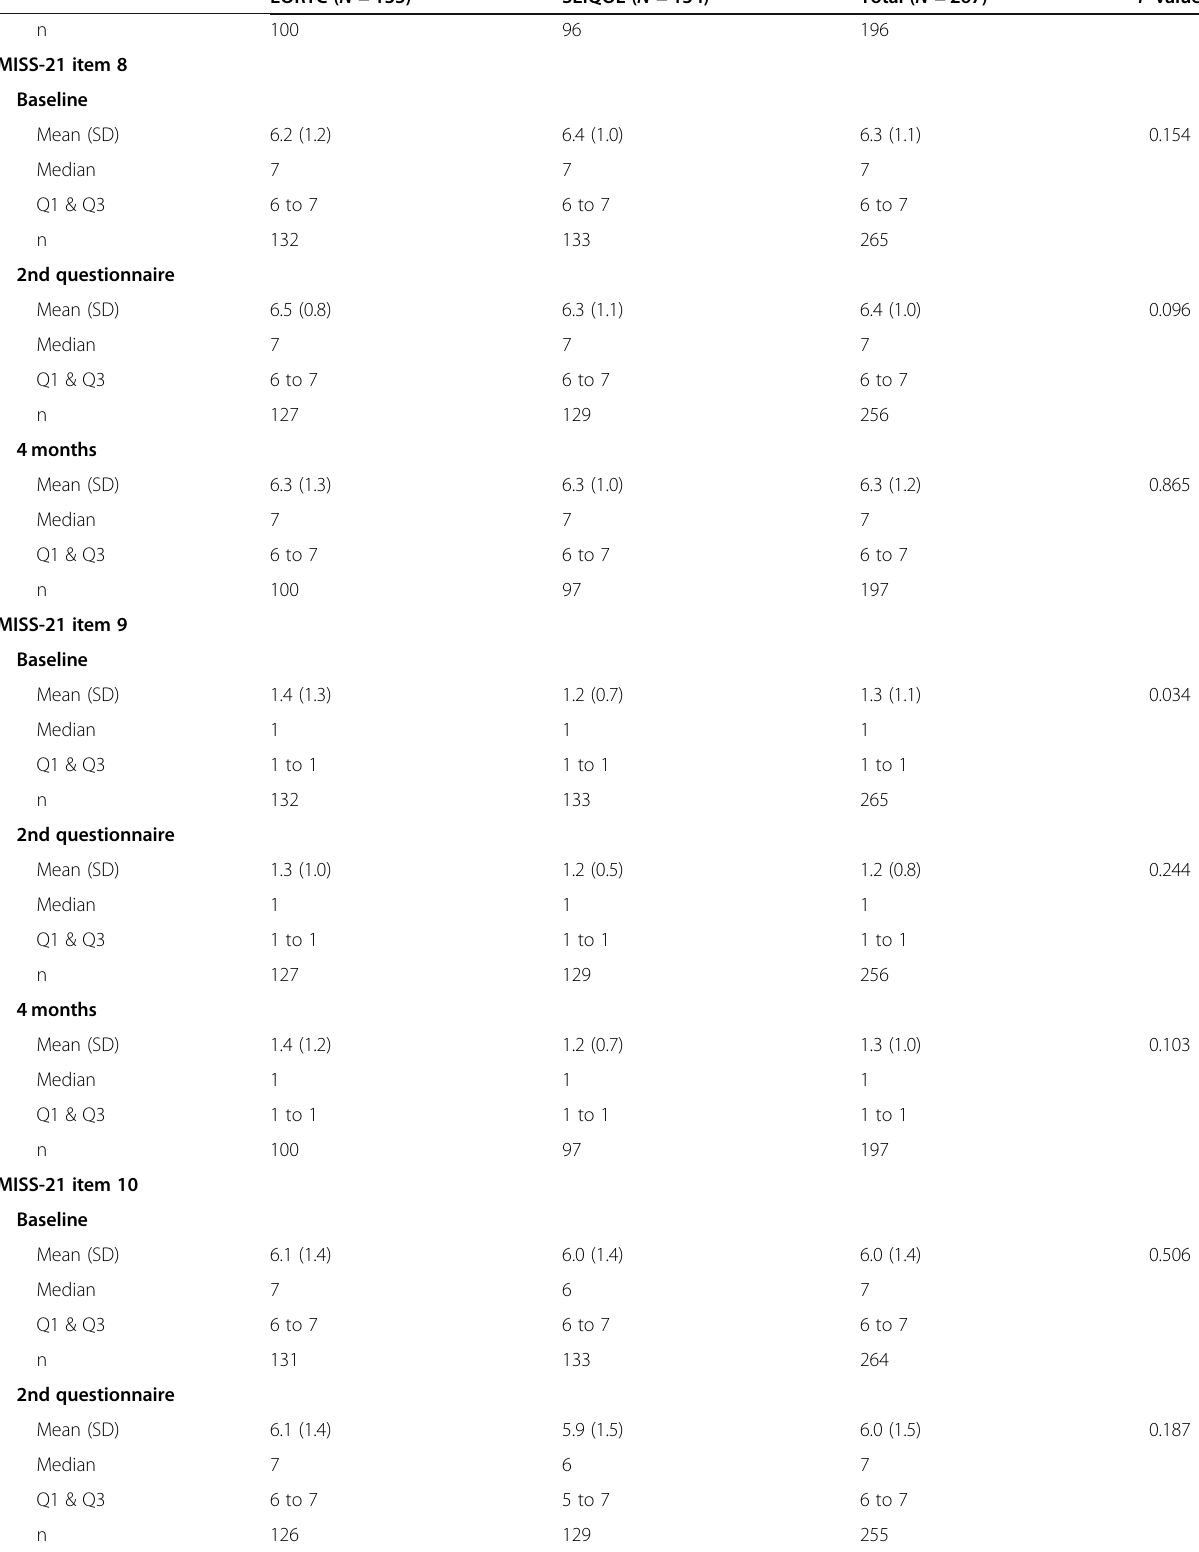
Table 2 Outcomes a over time for analyzed patients